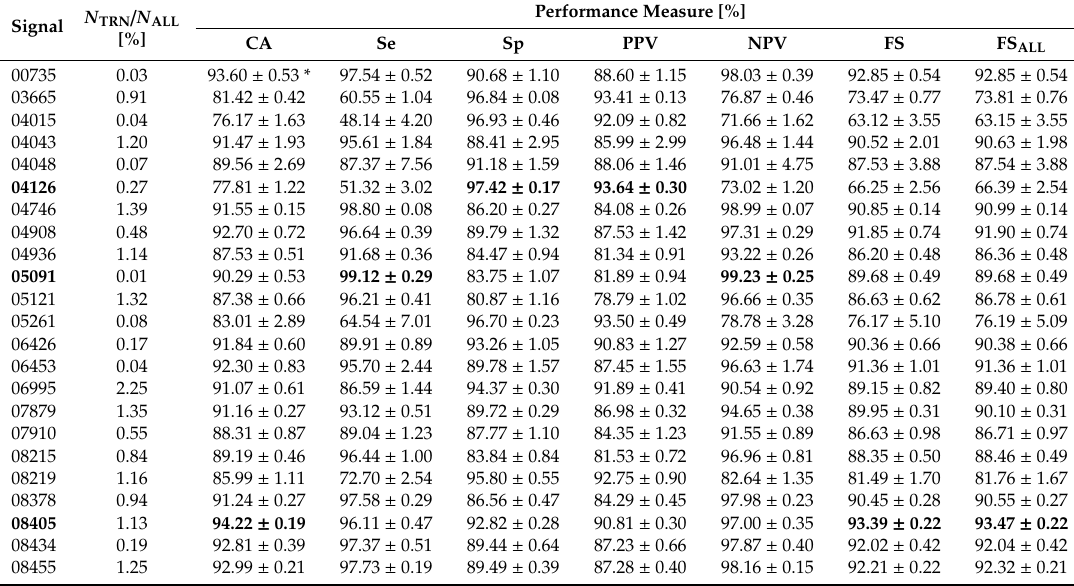
Table 2. The results of MIT-BIH AF database evaluation using the LSVM classifier ( γ = 10, χ = 4 ) trained with the balanced data separately extracted from each of the signal. The second column provides the percentage of the size of the training data ( N TRN ) to the number of all heartbeats ( N ALL ) in the MIT-BIH AF database. Columns 3–8 shows the results for testing data only (not used during the learning phase), the last column presents the F-Score values (FS ALL ) calculated using all heartbeats from the MIT-BIH AF database. The best results are in boldface.